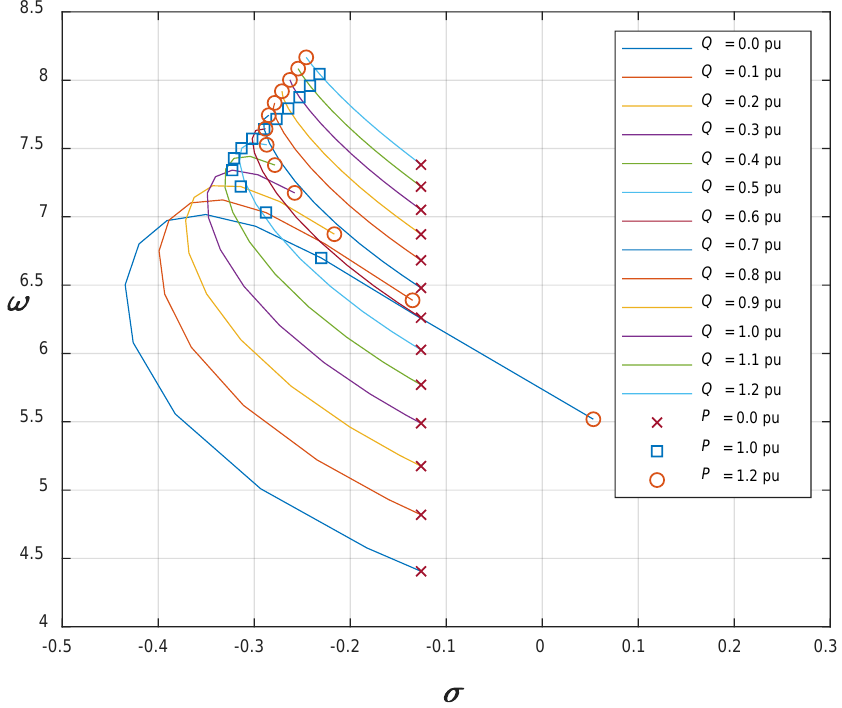
Figure 17. Eigenvalue loci of local mode of 160-MVA turbo-type synchronous generator with AVR.